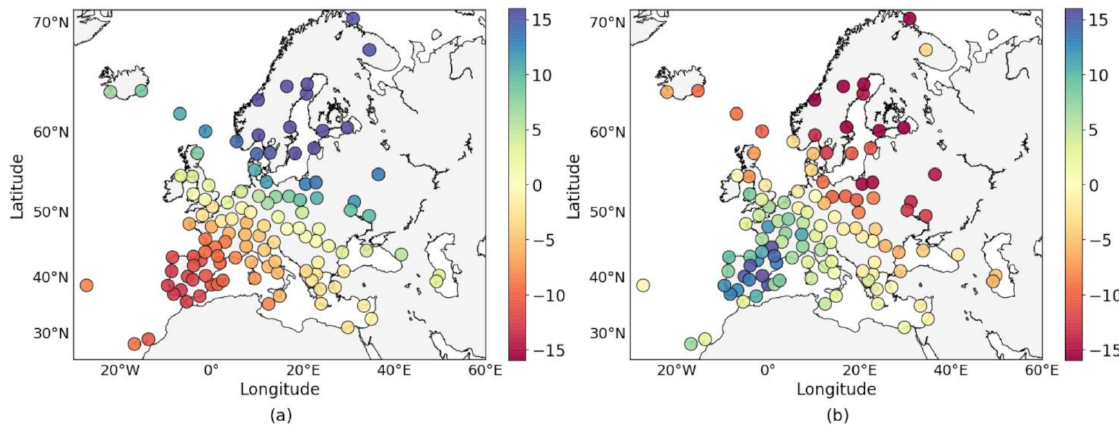
Figure 10. Spatial pattern coefficients describing the second SVD of the residuals of the SP and those of the Up coordinate. ( a ) SP spatial pattern; ( b ) Up spatial